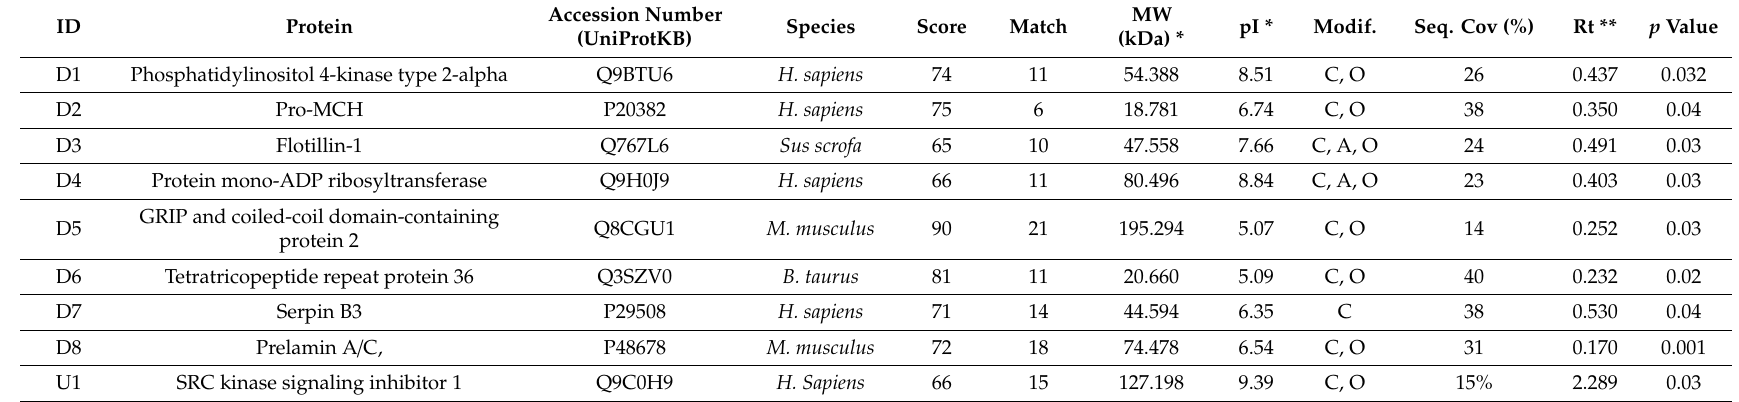
Table 2. Significantly ( p ≤ 0.05) di ff erentially expressed proteins in diabetic dogs as identified by MALDI-TOF